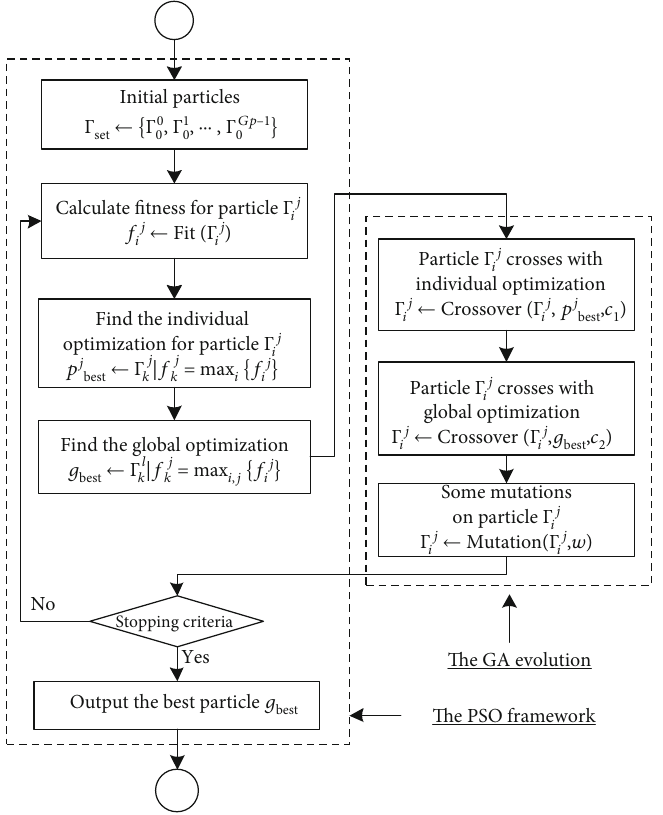
Figure 6: The main steps of the HPG4TT